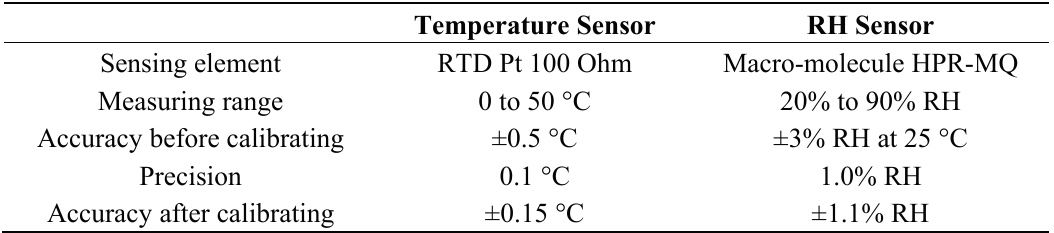
Table 1. Specification of the Shinyei THT-B121